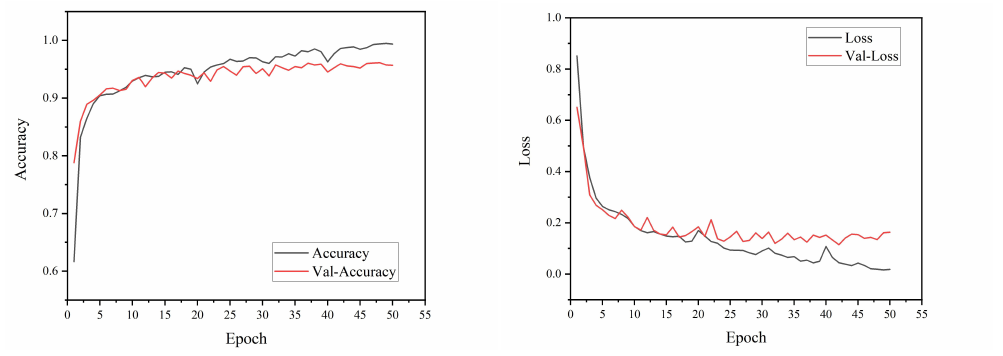
Figure 6. Accuracy and Loss Curves of CNN Model